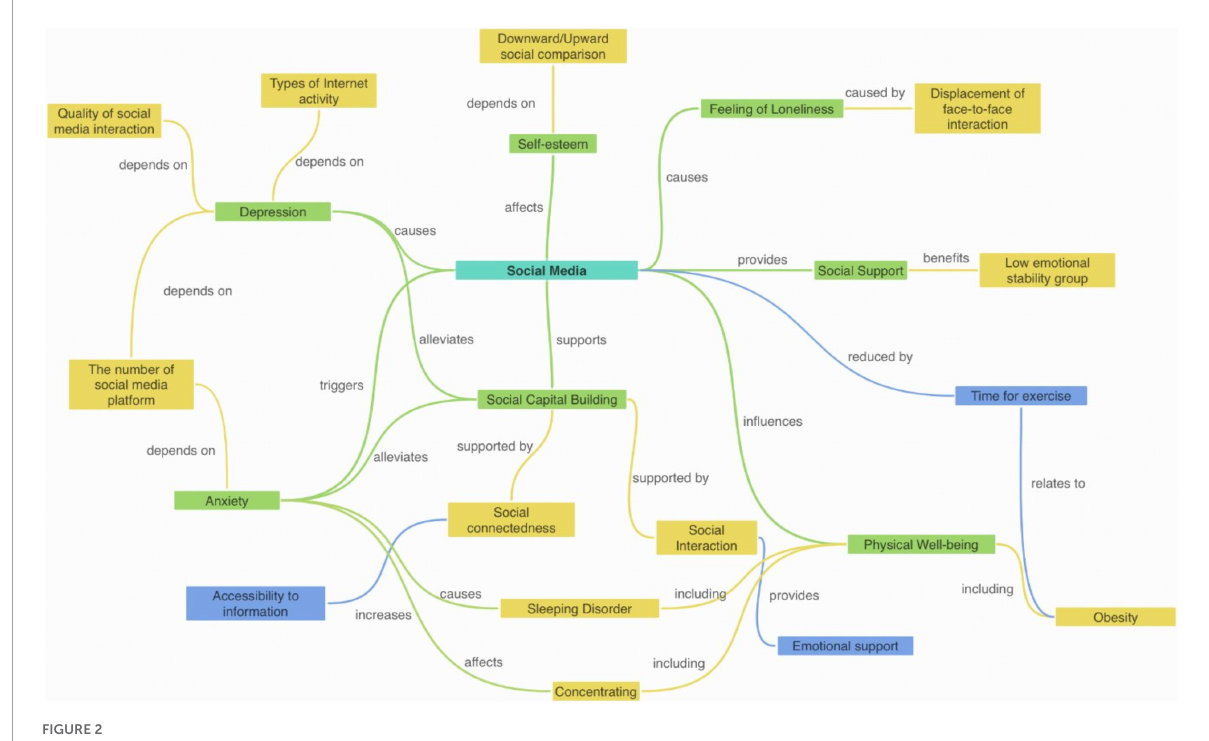
FIGURE2 The concept map for the collaborative learning